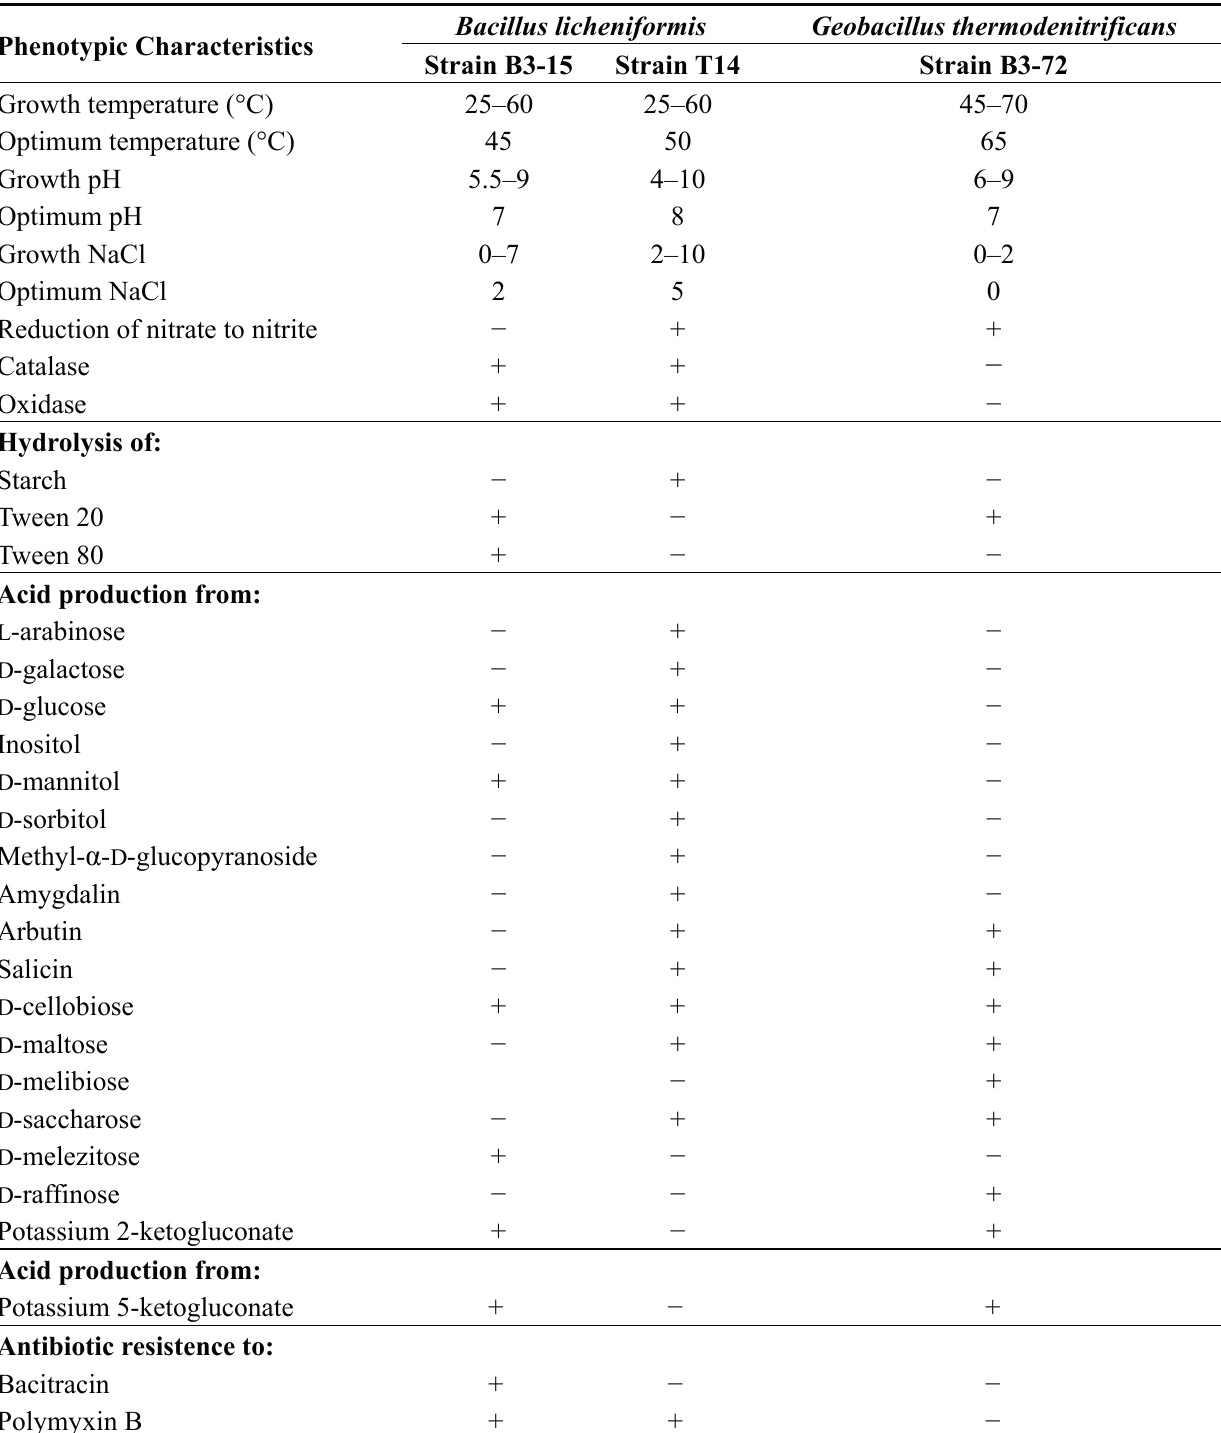
Table 2. Differential phenotypic characteristics of the bacilli producing exopolysaccharides, isolated from Eolian shallow